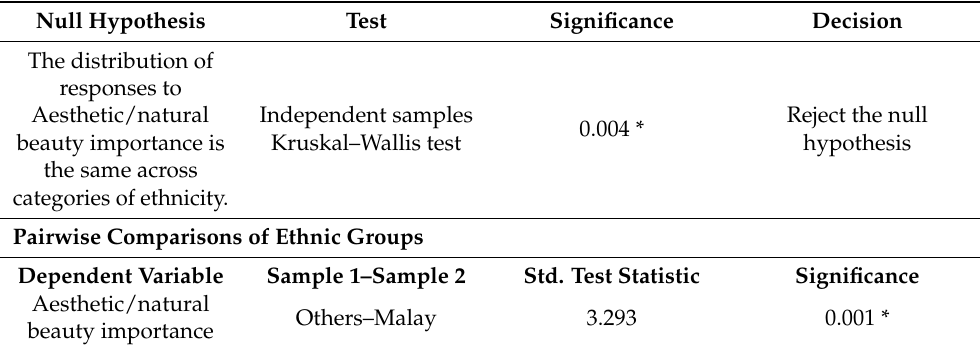
Table 8. The difference in responses to aesthetic/natural beauty importance between ethnic groups.